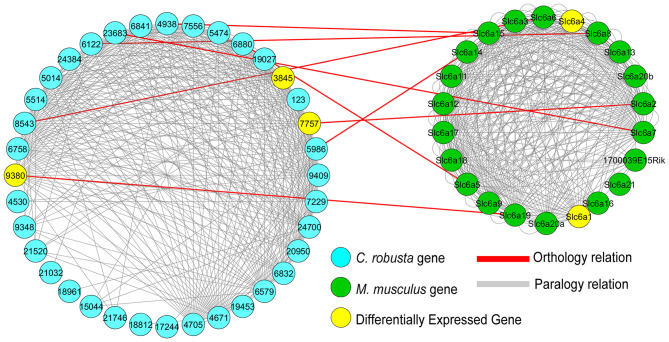
Network of Ciona and mouse Slc6 paralogs and their orthology relationships. Ciona ENS_07757 has 35 paralogous genes (light gray edges), and among them, ENS_09380 and ENS_03845 are downregulated in the OC:Act condition (Supplementary Table 1), while mouse Slc6a2 has 22 paralogous genes. The two paralogous gene networks are connected not only by the orthology relationship between ENS_07757 and Slc6a2 but also by other seven relationships. Though none of the eight mouse genes that have orthology relationships with Ciona genes (red edges) are differentially expressed genes (DEGs) in the mouse Oc1/Oc2−/− KO transcriptome, two alternative genes (Slc6a1 and Slc6a4) among their paralogs are actually DEGs in mouse (Sapkota et al., 2014). Differentially expressed genes in both Ciona (ENS_03845, ENS_07757, and ENS_09380) and mouse (Slc6a4 and Slc6a1) are shown in yellow. Light blue nodes: Ciona Slc6 paralogs (“ENS_” in the gene names is omitted); green nodes: M. musculus paralogs. The visualization was obtained with Cytoscape (Shannon et al., 2003).